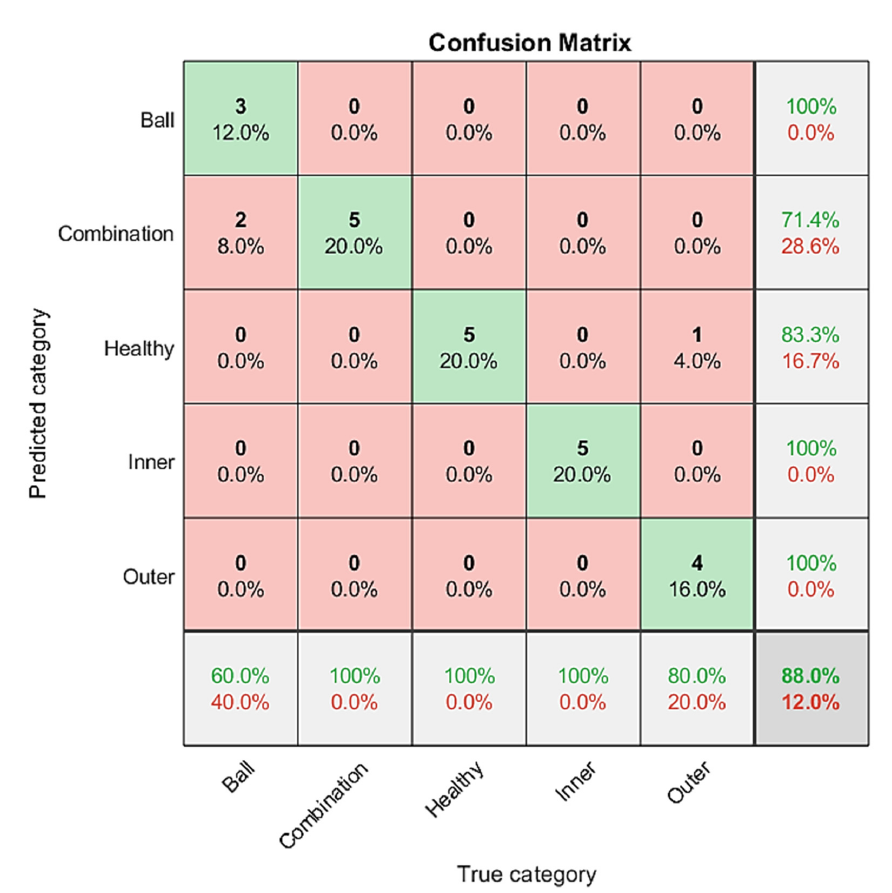
Table 2. Comparing the computing time and accuracy of different models.